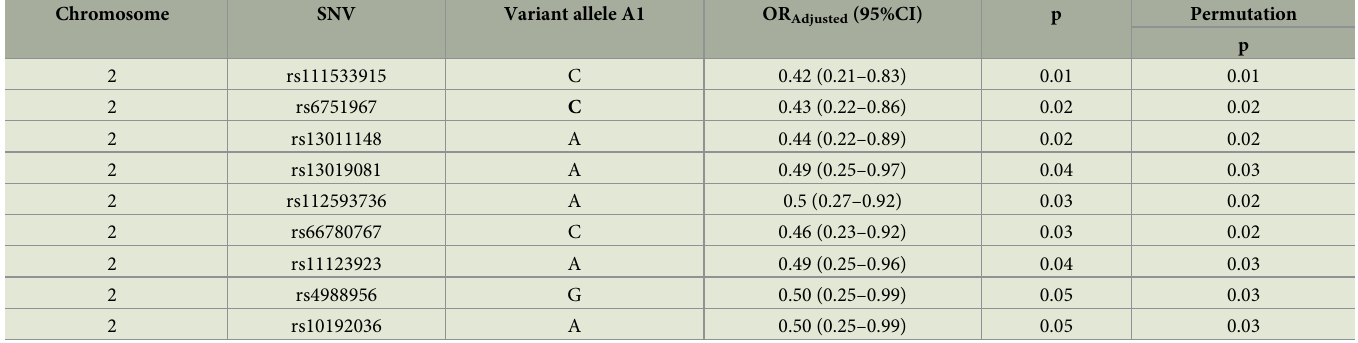
Table 3. Adjusted association measurements, odds ratio and 95% confidence interval, between the SNVs of the ST2 gene and Aggregatibacter actinomycetemcomi- tans relative amount, considering dominant genetic model.